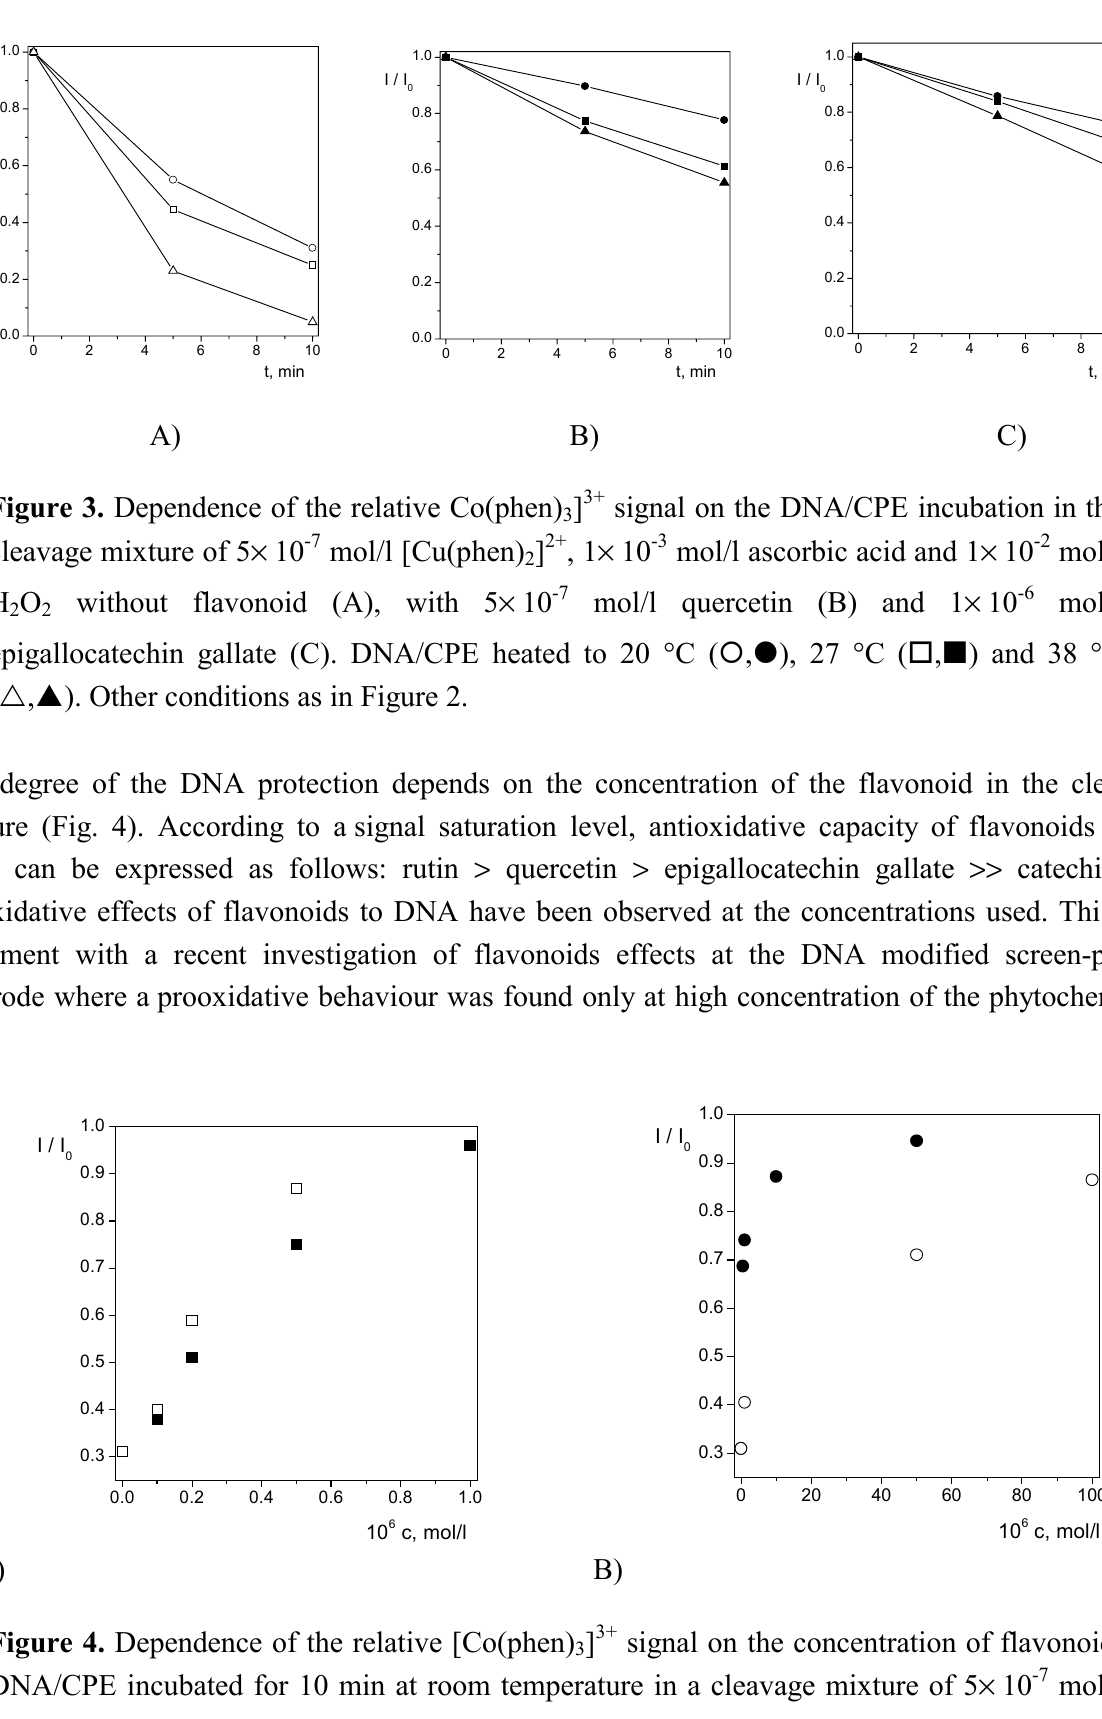
] 3+ signal on the concentration of flavonoid. 3 O and (A) quercetin ( (cid:2) ) or 2 2